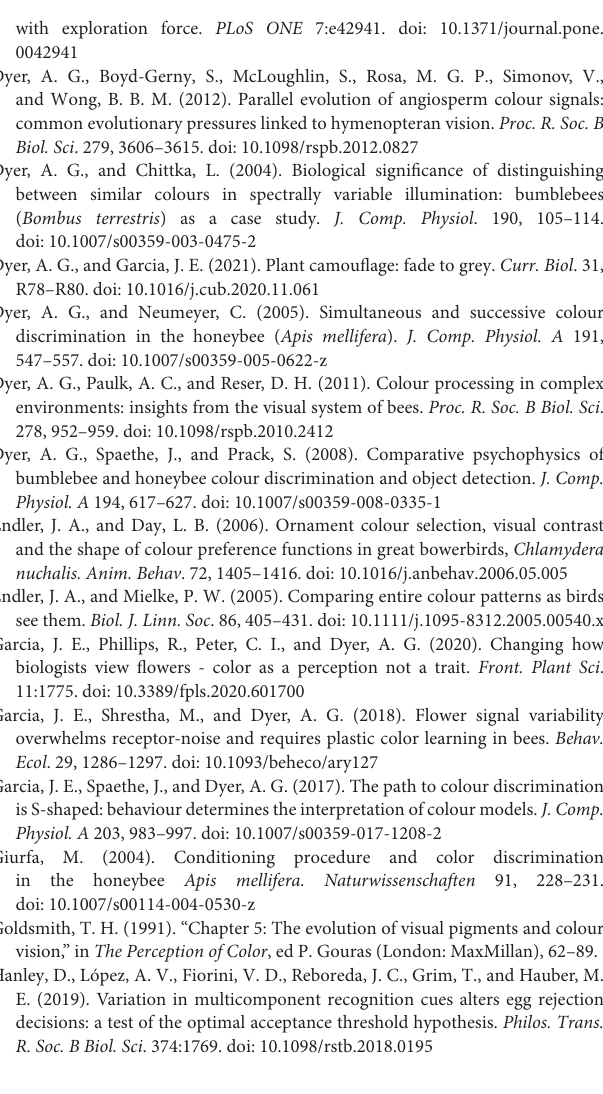
the interference filters used for the behavioural experiment, and median and 95% credibility intervals for the α i parameters corresponding to the random term in Equation (4),